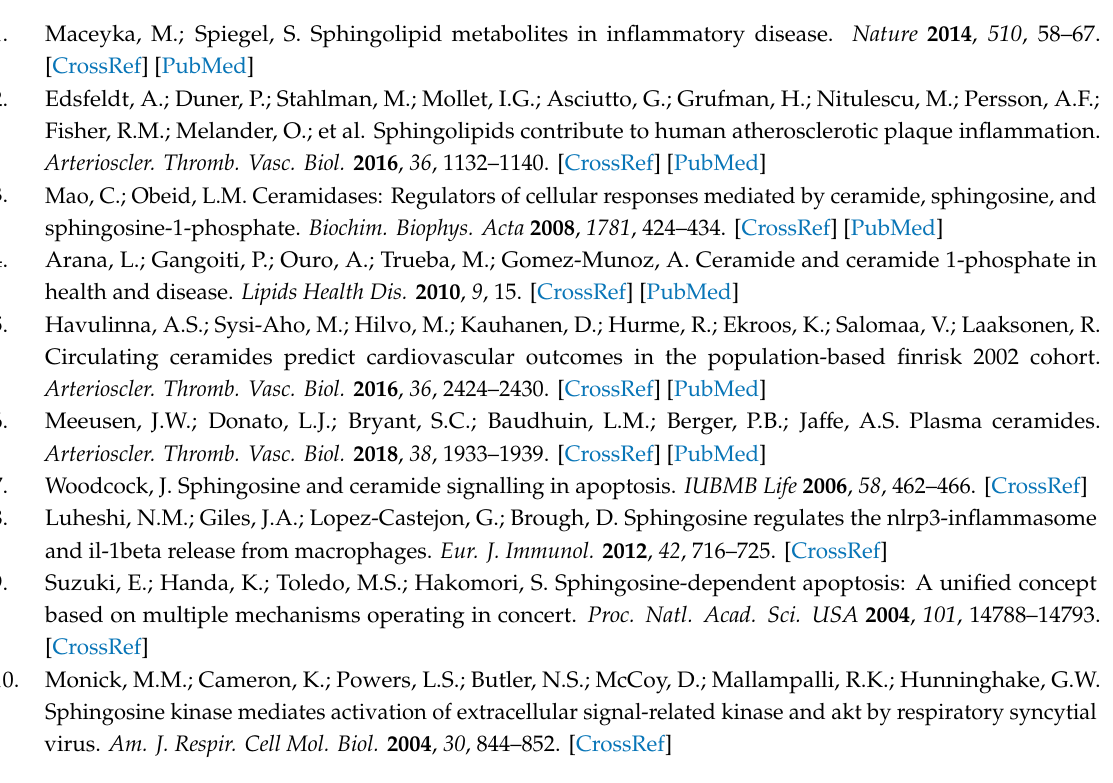
Figure S1: Modification of LDL by Sph enrichment and SMase treatment, Table S1: Apoptosis (% apoptotic cells) induced in the absence (blank) or presence of inhibitors at 10 µ M ( n = 5), * vs. blank, p <